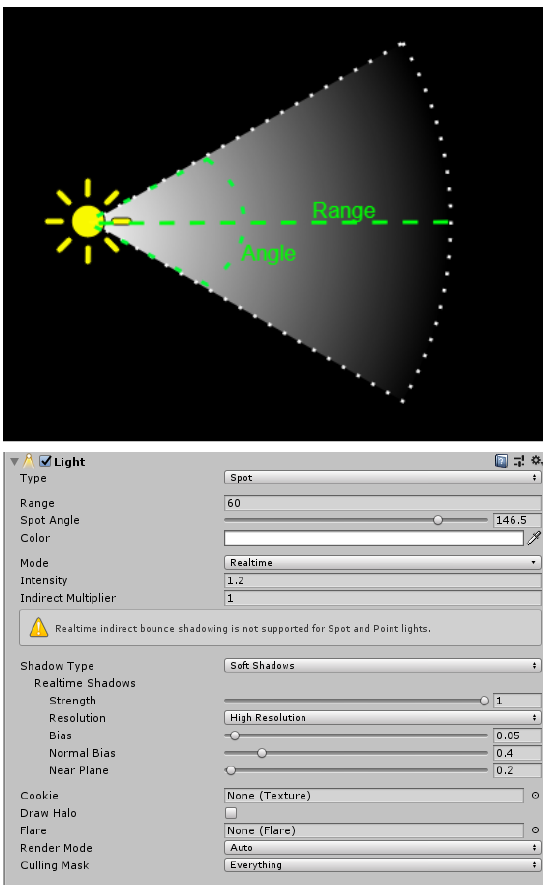
Figure 7. An image of the operation of a spot light ( top ) and a screenshot of the options chosen in our virtual reality system for the simulation of lights ( bottom